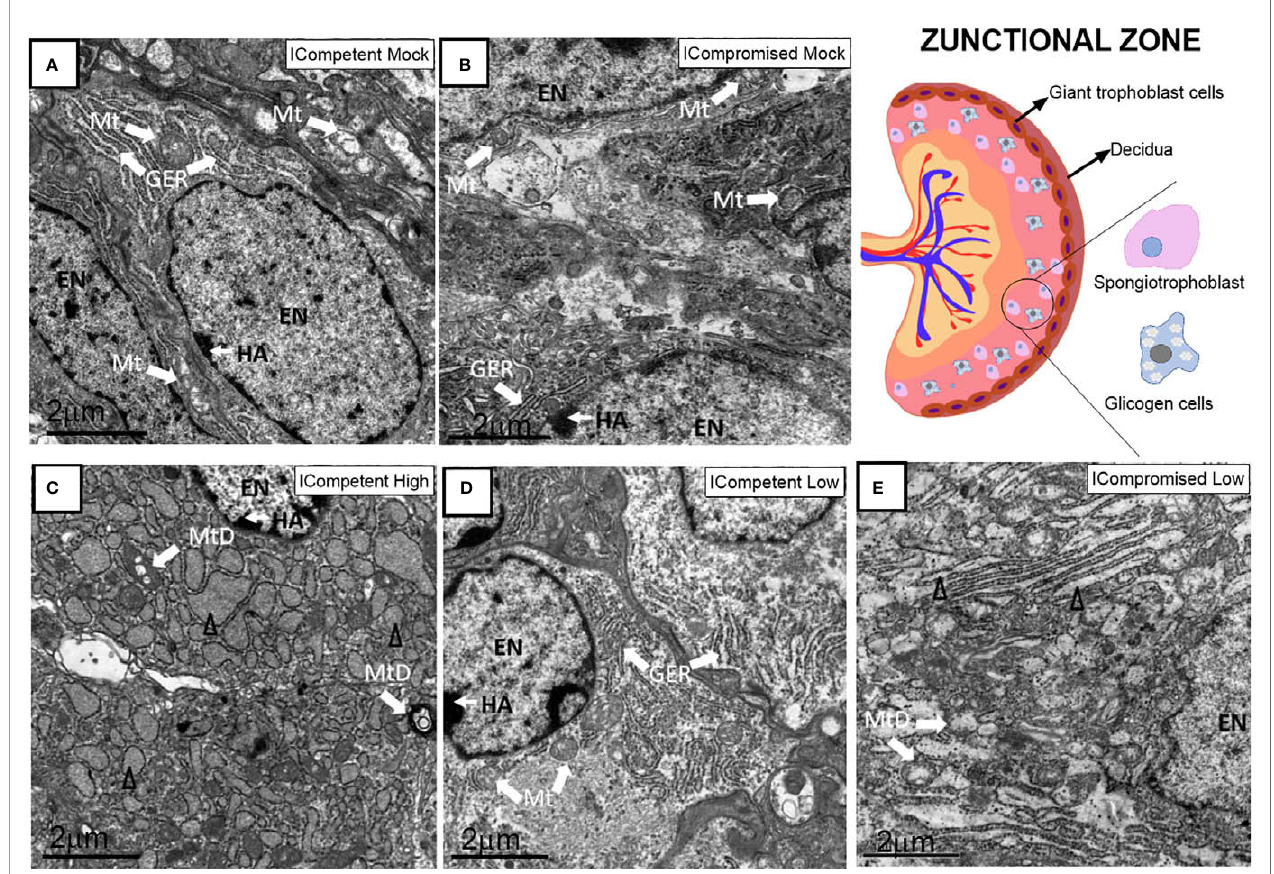
FIGURE 7 | Associated ultrastructural changes in the placental Jz after ZIKV infection. Transmission electron photomicrographs of ICompetent mock (A) , ICompromised mock (B) , ICompetent high (C) , ICompetent low (D) and ICompromised low (E) groups (n=5/group). We found deteriorating mitochondria and dilated reticulum endoplasmic cisterns in both the high ICompetent and low ICompromised groups. GER, granular endoplasmic reticulum; D , dilated granular endoplasmic reticulum; Mt, mitochondria; MtD, degenerate mitochondria; Mv, microvilli; EN, euchromatic nuclei; SS, sinusoidal space; TGC, trophoblastic giant cell; HA, heterochromatin area. Scale bar = 2